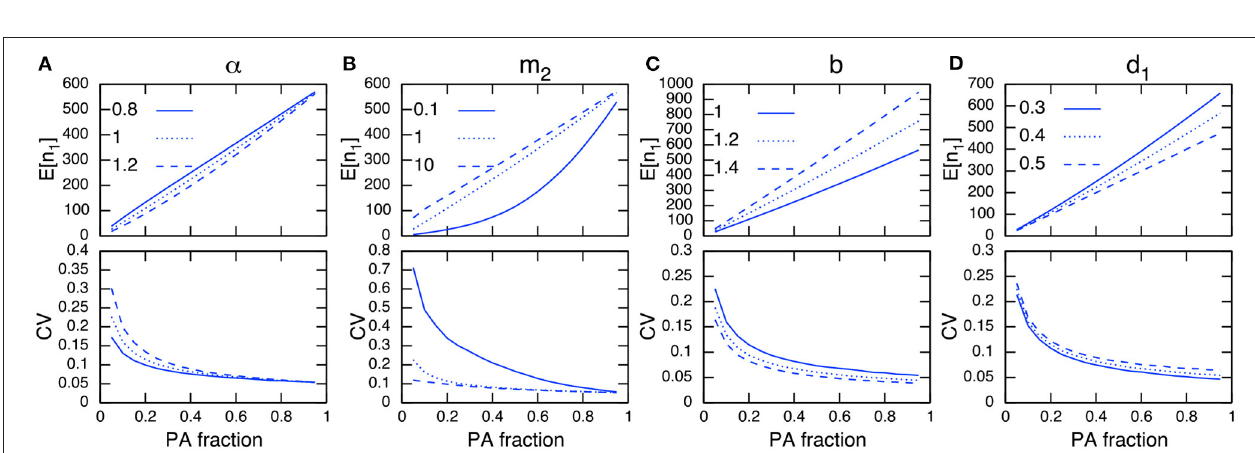
FIGURE 4 | Parameter dependence on E[ n 1 ] (top) and CV in protected areas (bottom) under demographic stochasticity. The parameters being examined are α (A) , m 2 (B) , b (C) , and d 1 (D) . Other parameter values used (unless specified) are b = 1, d = 0.001, d 1 = 0.4, d 2 = 0.5, m 1 = 1, m 2 = 1, and α = 1. Note the site preference is α < 1 when PAs are preferred and α > 1 when non-PAs are preferred.